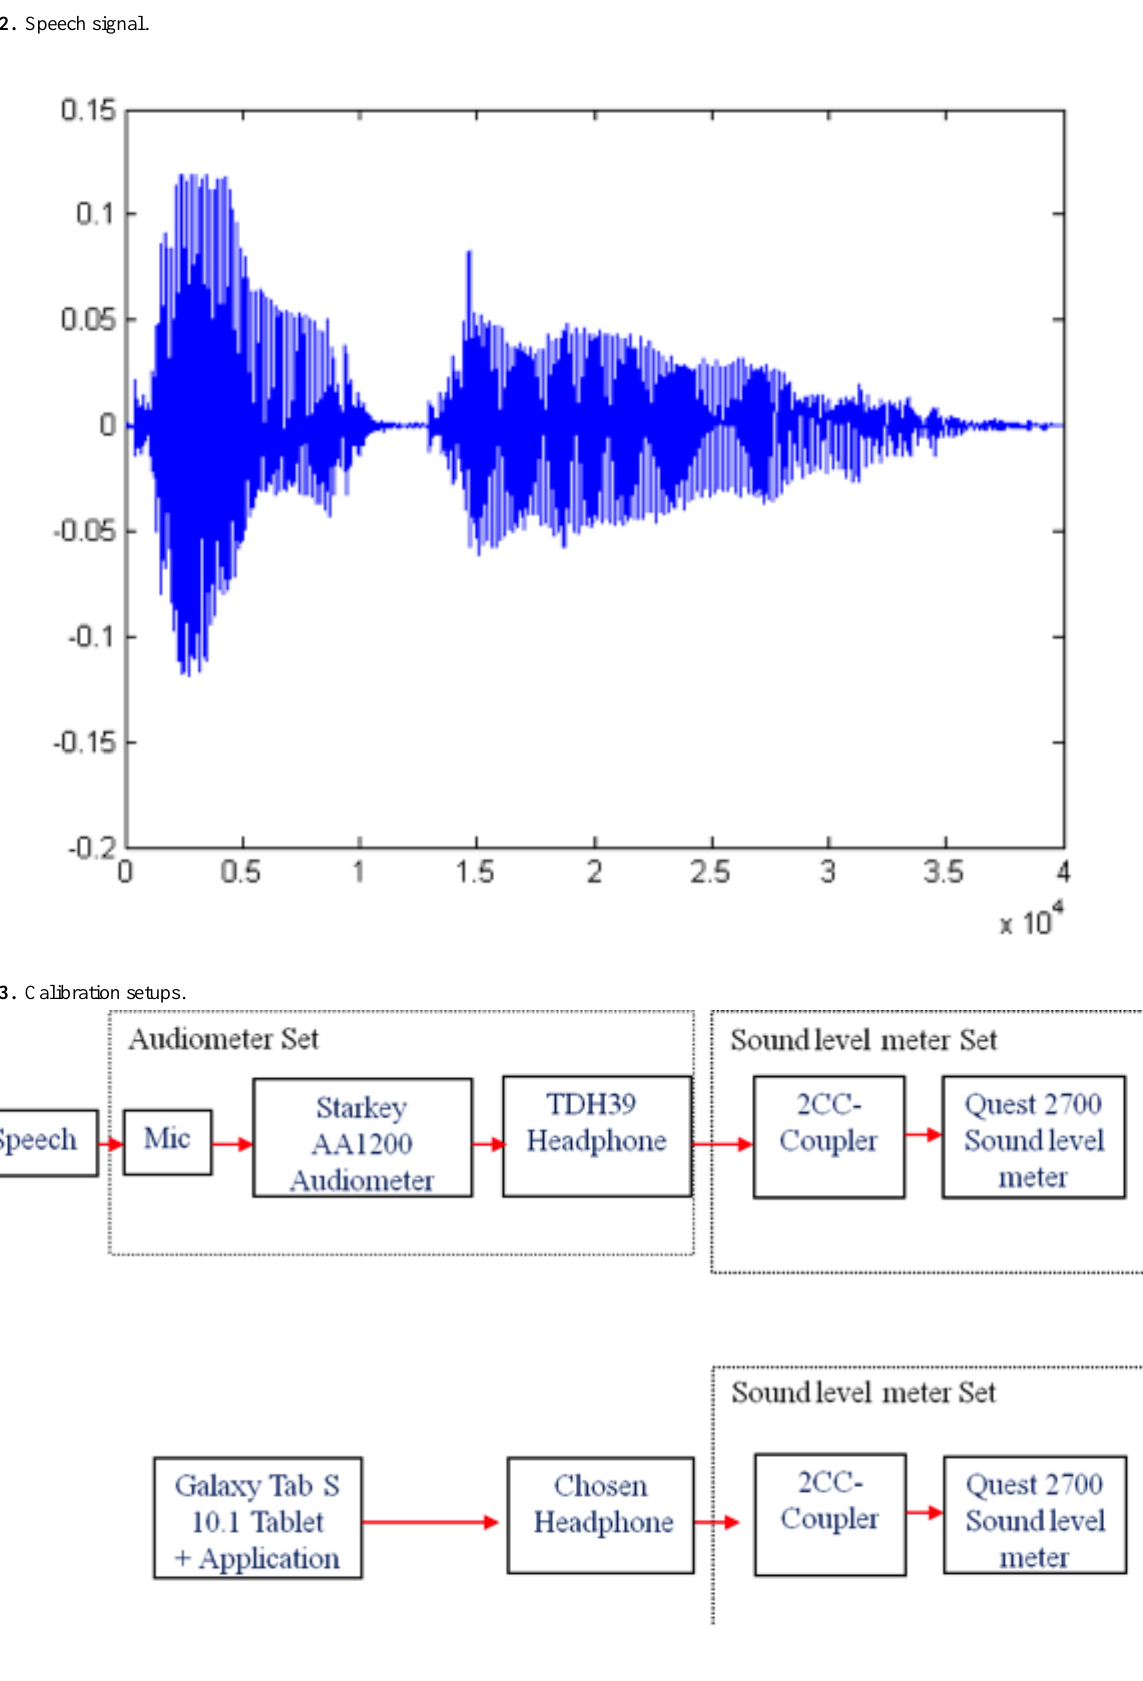
Figure 2. Speech signal.